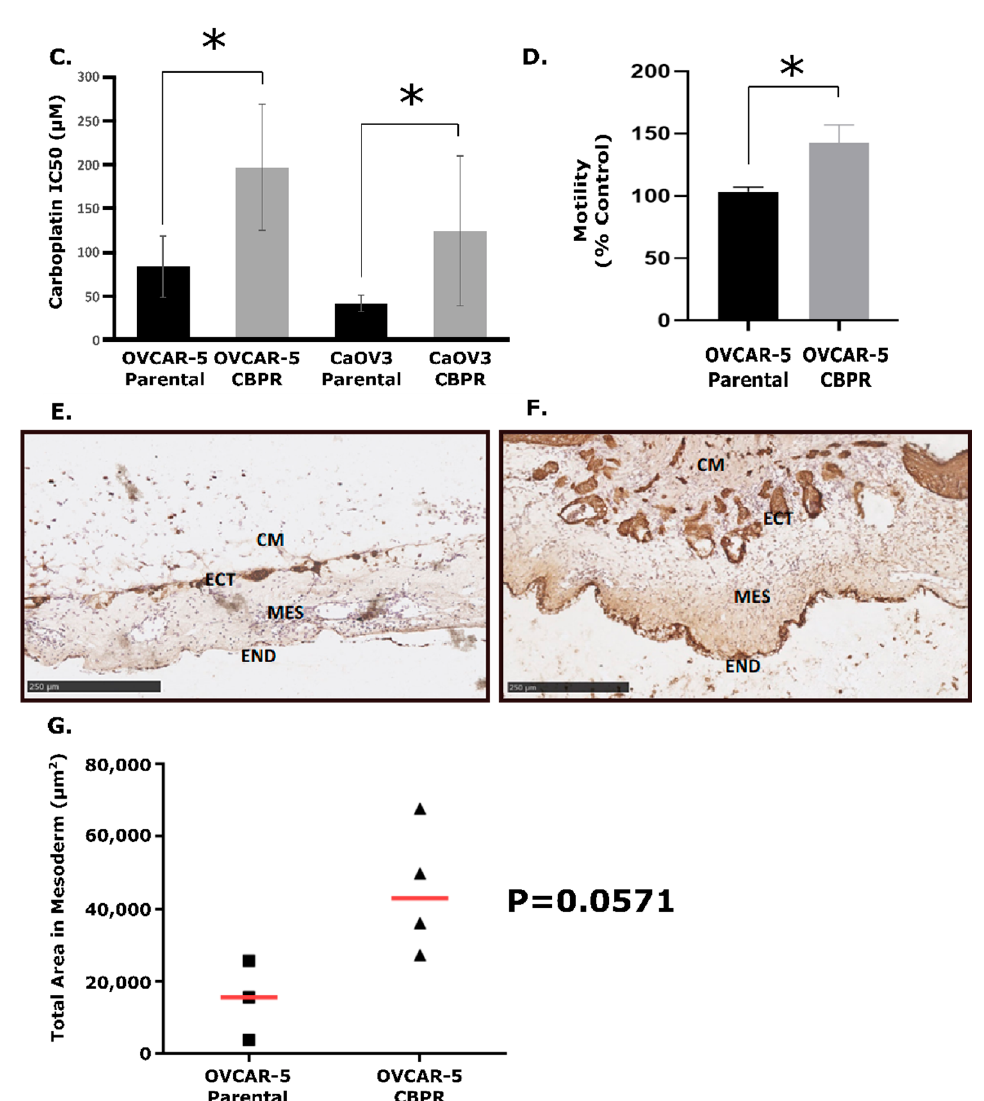
Figure 1. Biological data for carboplatin-resistant cancer cell lines. Growth rates determined using an MTT assay of ( A ) OVCAR-5 parental vs. CBPR and ( B ) CaOV3 parental vs. CBPR show no significant difference (unpaired t -test, OVCAR-5: p = 0.331 and CaOV3: p = 0.818). ( C ) Dose response of OVCAR-5 and CaOV3 resistant and parental pairs to carboplatin. OVCAR-5 parental IC50 = 83.6 ( n = 8), OVCAR-5 CBPR IC50 = 1967.0 ( n = 8); CaOV3 parental IC50 = 41.9 ( n = 7), CaOV3 CBPR IC50 = 124.0 ( n = 7). Unpaired T test showed IC50 to be significantly higher in CBPR cell lines compared to their parental cells (OVCAR-5 p = 0.001, CaOV3 p = 0.02). ( D ) In vitro motility assay of OVCAR-5 parental compared to OVCAR-5 CBPR cell lines showed that OVCAR-5 CBPR is significantly more motile than its parental pair (unpaired t -test, p = 0.037). In vivo CAM invasion assay with OVCAR-5 parental ( E ) and OVCAR-5 CBPR ( F ). OVCAR-5 cell Matrigel grafts (CM) were placed in the top of the ectoderm (ECT) layer and cancer cell invasion into the CAM mesoderm (MES) layers was assessed on Day 14 of chick embryo development. END = endoderm CAM paraffin sections (6 µ m) were immunostained with pan-cytokeratin antibody. Scale bar = 250 µ m. ( G ) Quantification of OVCAR-5 parental ( n = 3) and OVCAR-5 CBPR ( n = 4) invasion into the CAM mesoderm. Data represents the total pan-cytokeratin positive area ( µ m 2 ) in the mesoderm area from 5 to 6 images per embryo. Mann–Whitney U test showed greater invasion in OVCAR-5 CBPR compared to parental cells ( p = 0.0571) (* = statistical significance, p <